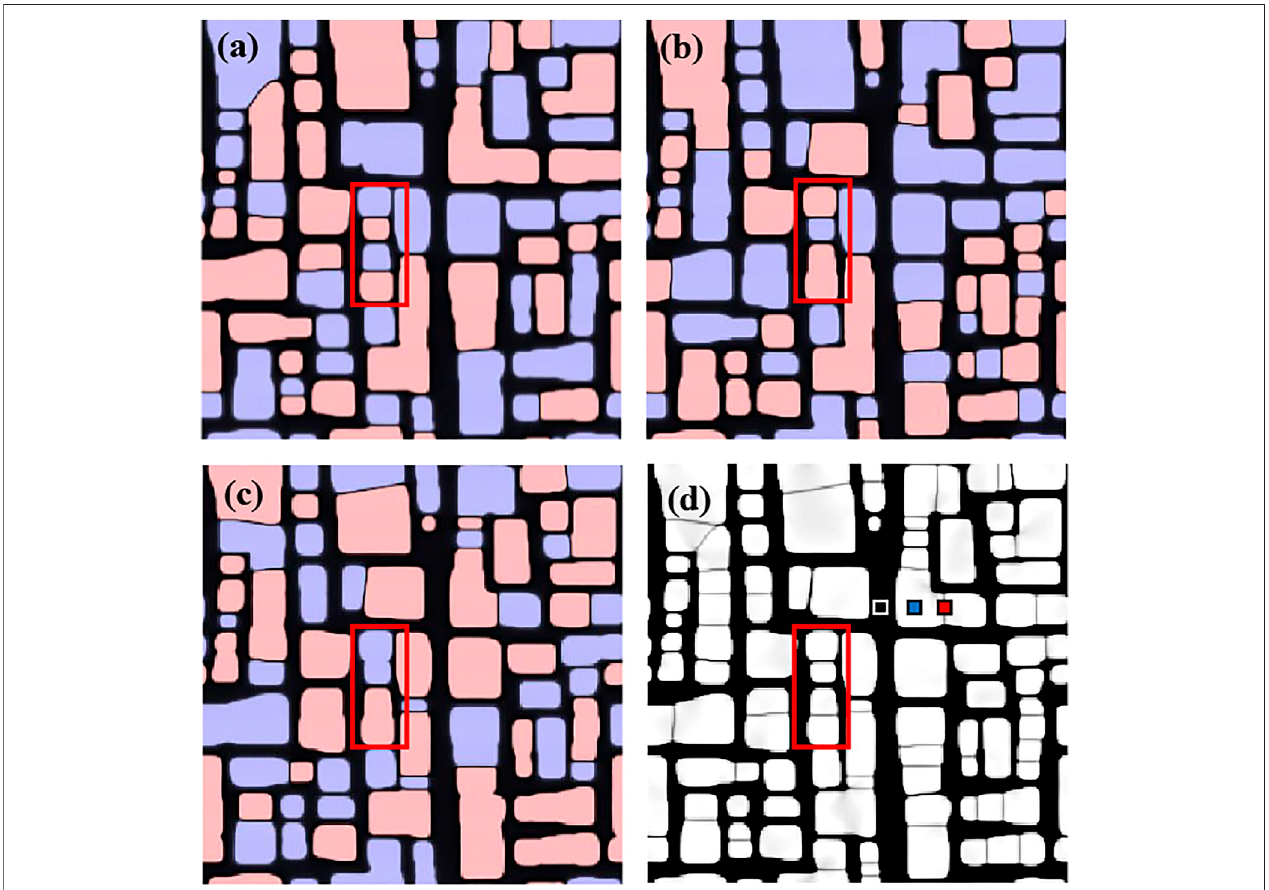
FIGURE 2 | Free energy variations in regions of APBs: (A) with aging time t from γ matrix to γ ʹ phase and (B) with edge-to-edge distance of two γ ′ phases.